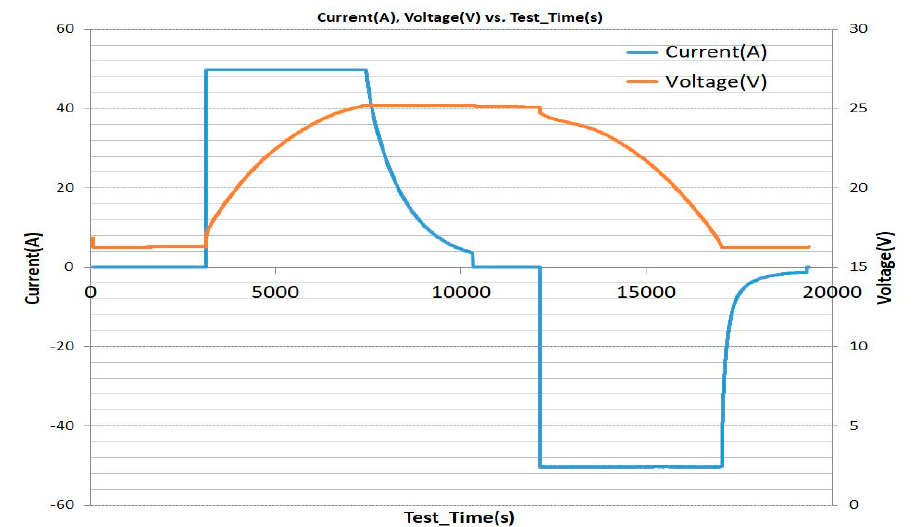
Figure 6. Battery current and voltage measured during the capacity test.